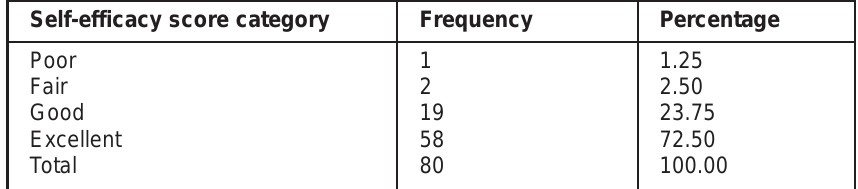
Table 2: Distribution of self-efficacy scores (n =